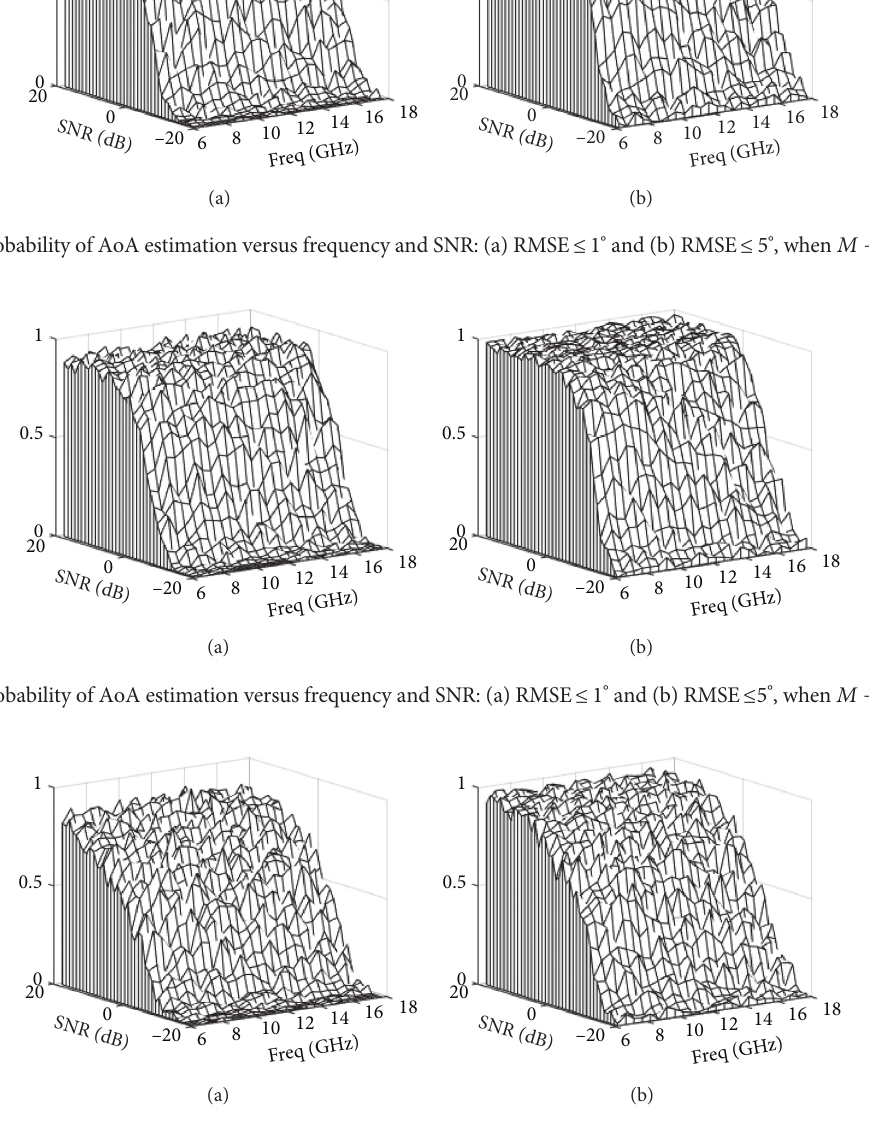
Figure 9: Array-3 probability of AoA estimation versus frequency and SNR: (a) RMSE ≤ 1 ° and (b) RMSE ≤ 5 ° , when M + 1 � 1025 for